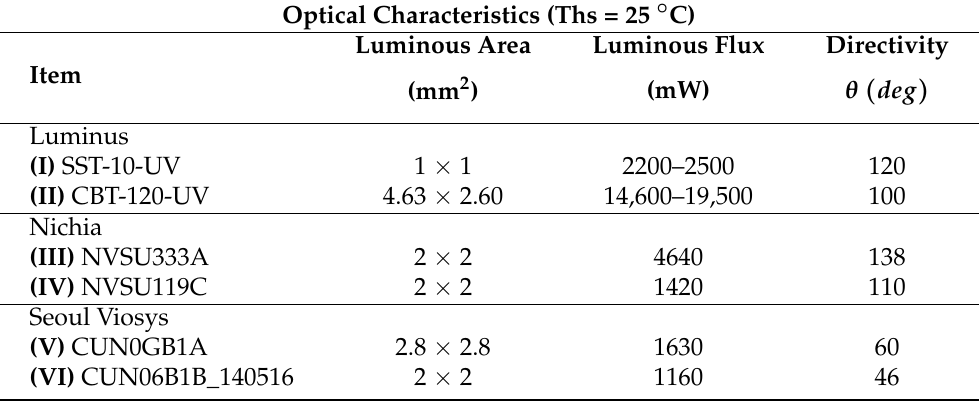
Table 1. Specification of commercial